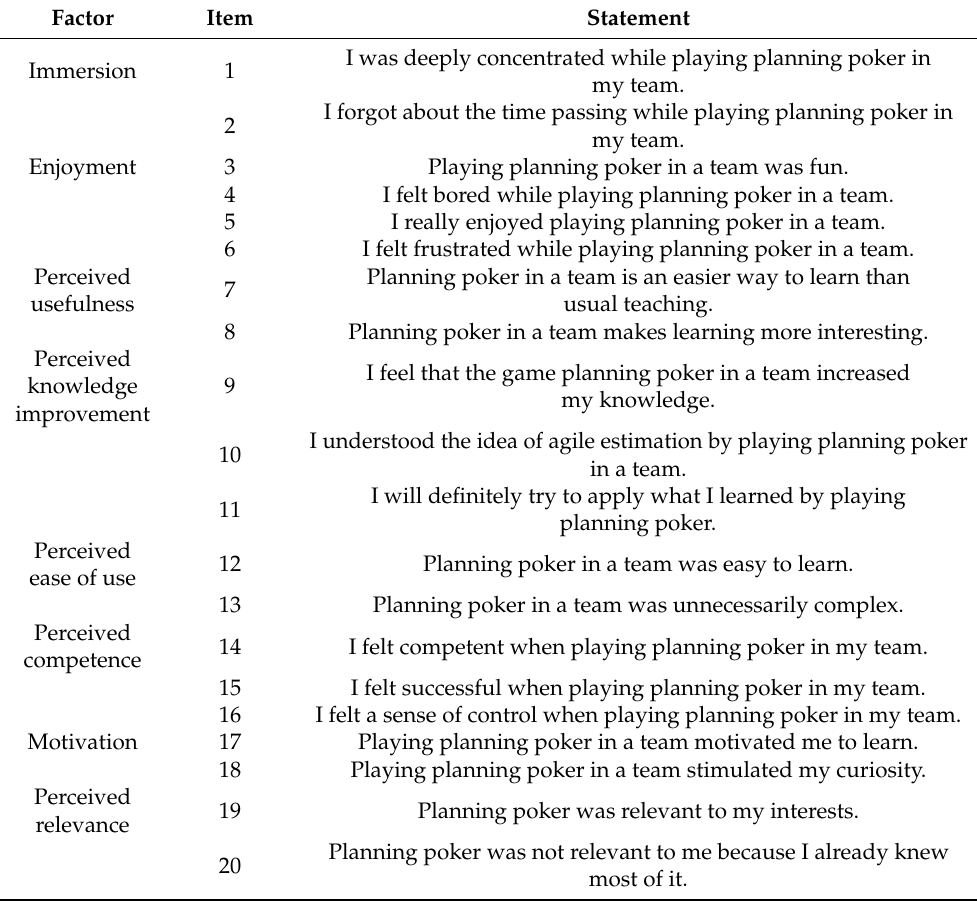
Table 1. Shortened learning experience scale with 20 items applied in the evaluation